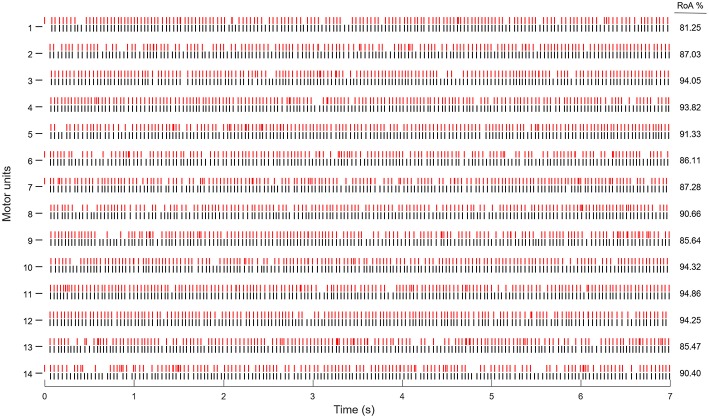
MU spike trains, identified from the simulated sEMG signal with 30 dB SNR and 10% excitation level (red), and the simulated firings (black). Each vertical line indicates one MU firing.